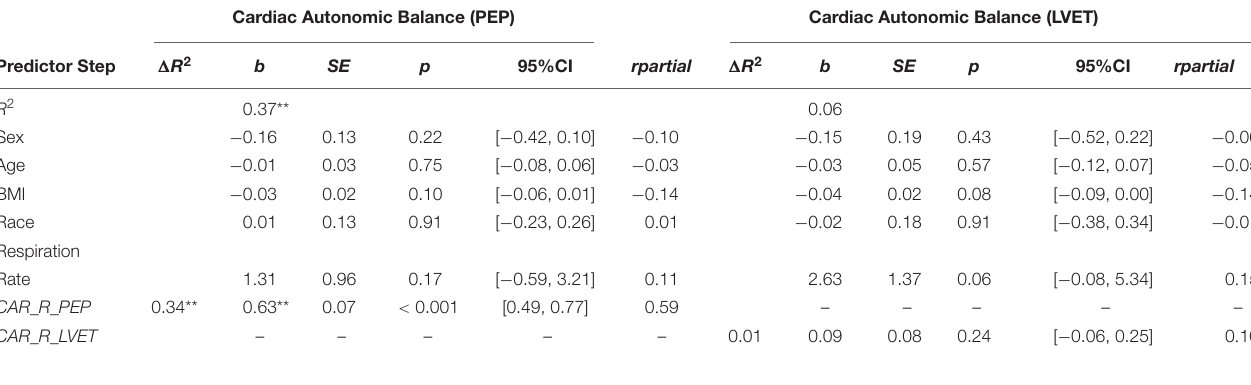
TABLE 5 | Hierarchical regression analyses calculated from RMSSD, PEP,